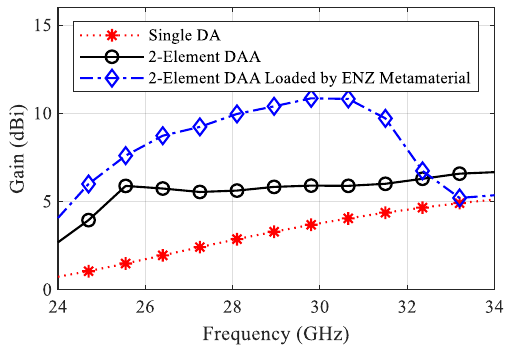
Figure 10. Gain versus frequency for all update steps.